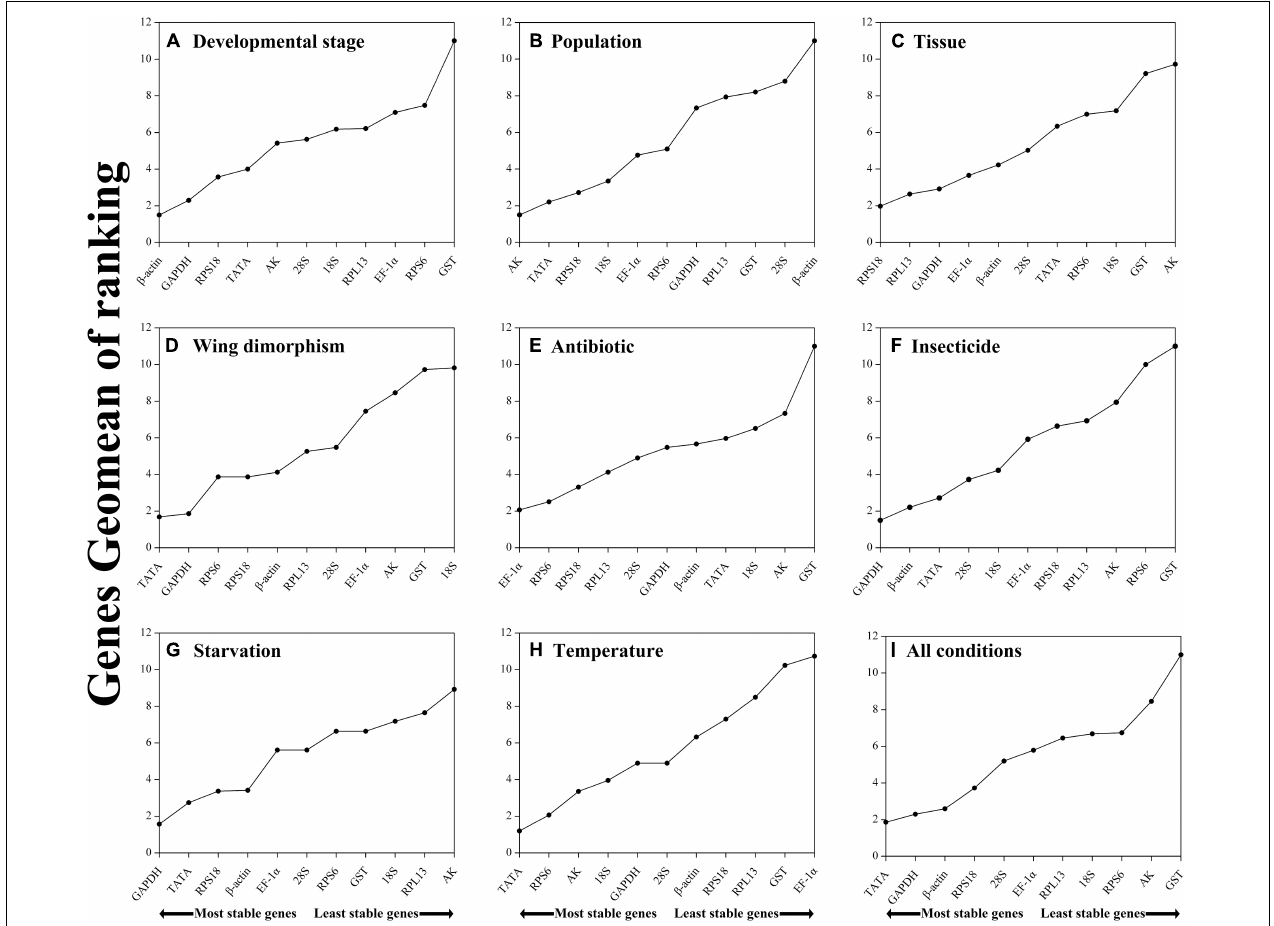
FIGURE 2 | Stability of candidate reference genes in R. padi under various experimental conditions. In a RefFinder analysis, increasing Geomean values correspond to decreasing gene expression stability. The Geomean values for the following R. padi samples are presented: (A) Developmental stage: samples for all developmental stages; (B) Population: adult samples from different geographical populations; (C) Tissue: samples for different tissues of wingless adults; (D) Wing dimorphism: samples for winged and wingless adults; (E) Antibiotic treatment: adult samples treated with different antibiotics; (F) Insecticide treatment: adult samples treated with different insecticides; (G) Starvation: fed and unfed adult samples; (H) Temperature: adult samples exposed to different temperatures; (I) All conditions: all samples for all treatments. The candidate reference genes are as follows: EF-1 α , elongation factor 1 α ; β -actin ; AK , arginine kinase ; TATA , TATA-box binding protein ; GAPDH , glyceraldehyde-3-phosphate dehydrogenase ; GST , glutathione S-transferase ; RPL13 , ribosomal protein L13 ; RPS6 , ribosomal protein S6 ; RPS18 , ribosomal protein S18 ; 18S , 18S ribosomal RNA ; 28S , 28S ribosomal RNA